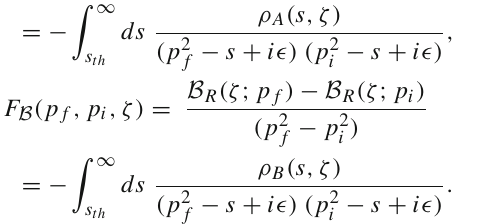
Fig. 1 The pictorial representation of the regularized fermion-photon vertex, with a fermion absorbing a photon